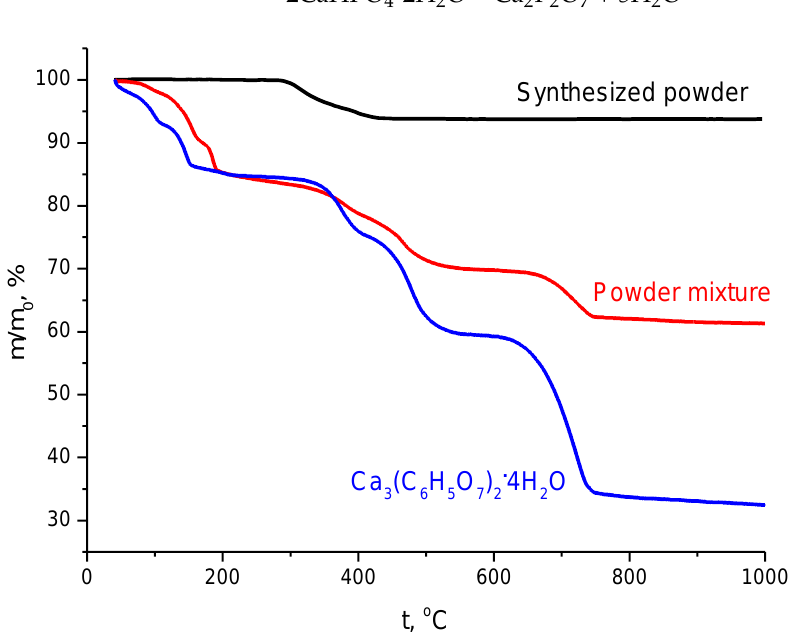
Figure 4. Thermal analysis data for the synthesized powder (in black), calcium citrate tetrahydrate Ca 3 (C 6 H 5 O 7 ) 2 · 4H 2 O (in blue), and their powder mixture (in red).